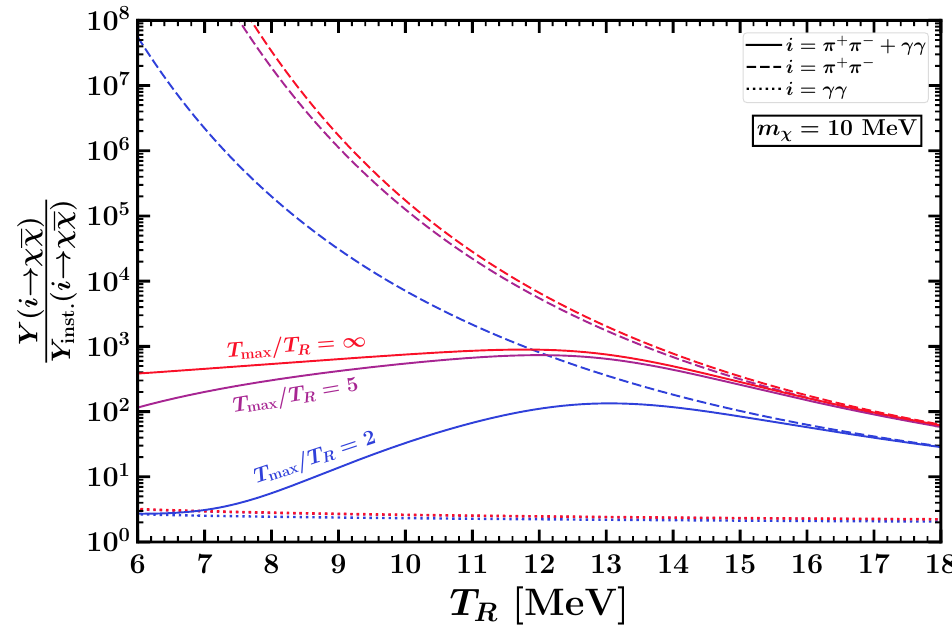
Figure 4 . The ratio of the total dark matter yield to the yield obtained only with the instantaneous reheating approximation, as a function of T R for m χ = 10 MeV. The different colors correspond to different T max /T R , while the different line styles correspond to different sets of initial SM